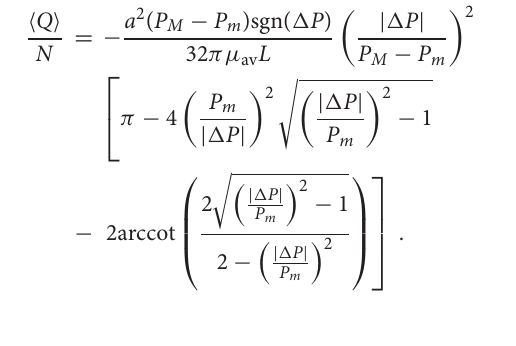
FIGURE 2 | Results from numerical simulations performed with N drop 1 P for different threshold distributions are shown in (A–C) where non-linear to linear transitions are observed while increasing the pressure drop. (A) Corresponds to uniform threshold distribution (Equation 5) where the power-law exponent γ for the non-linear regime has a value 2 without a lower cut-off ( P m 0). With any non-zero lower cut-off ( P m > 0), the exponent shifts to 3 / 2 (Equation 23). Results for the threshold distribution with a power α (Equation 24) are = shown in (B,C) for P m 0 and P m > 0, respectively, where γ varies with α as γ = (D) for the range of α which show two distinct straight lines for P m as shown in the insets of (B,C)